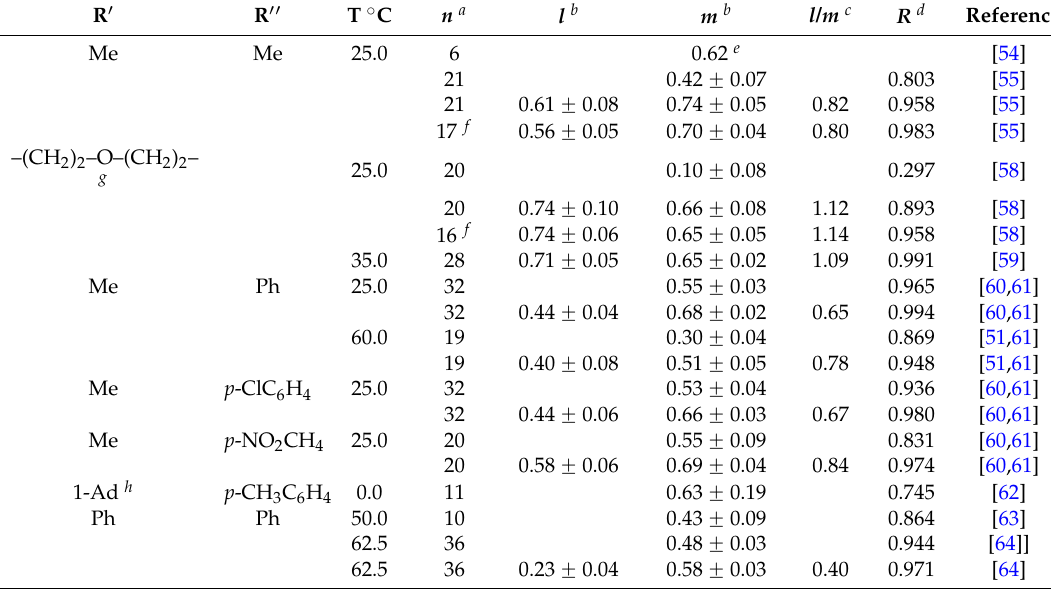
a Number of Solvents; b With accompanying standard error; c Useful for assigning mechanism. The l/m values for phenyl chloroformate of ca . 2.96 and for phenyl chlorodithioformate of ca . 0.72 [17] are often taken as typical values for addition-elimination reaction, with addition rate-determining, and for ionization with moderate assistance from nucleophilic solvation, respectively; d Multiple correlation coefficient; e Calculated using the original Y scale, which is based on the first-order rate coefficients for solvolyses of tert -butyl chloride; f With omission of the four 2,2,2-trifluoroethanol (TFE)-ethanol mixed solvents; g Morpholine with an N